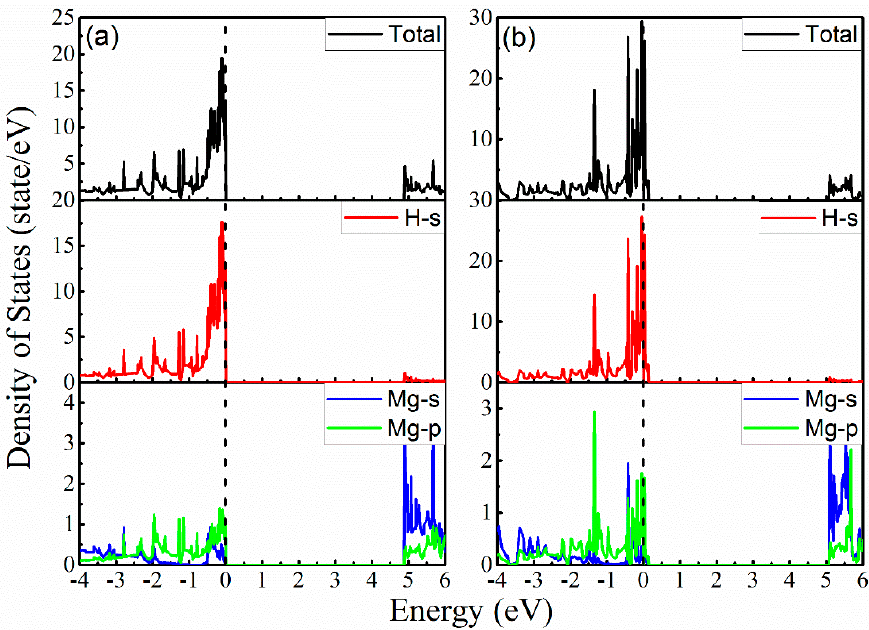
Figure 3. The total and partial densities of states of pure ( a ) and defective ( b ) Mg 9 H 18 .